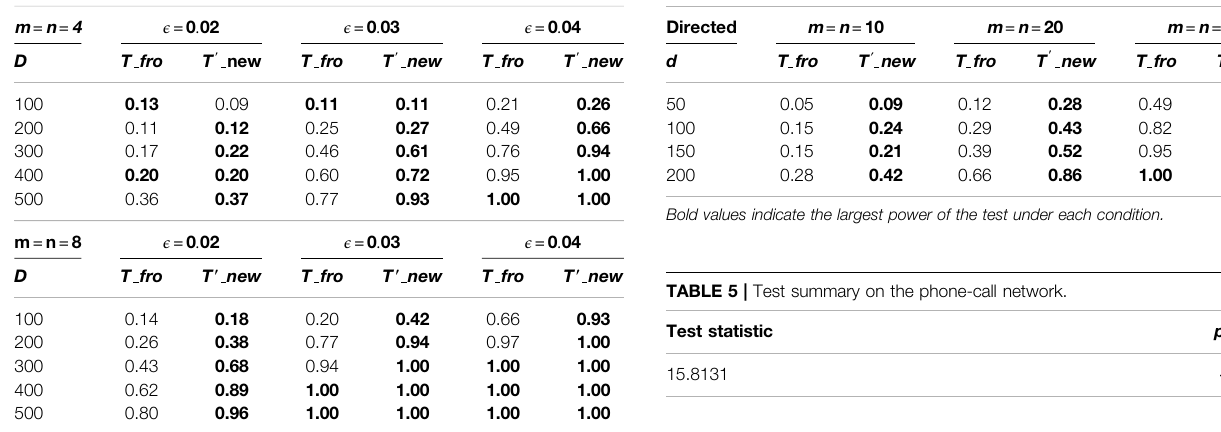
TABLE 4 | Power comparison of different tests for directed graphs with varying sample sizes.